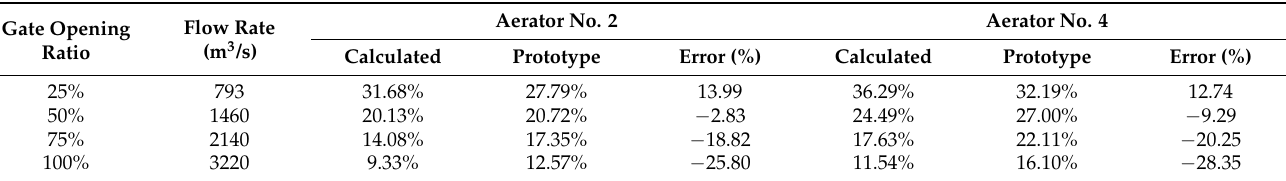
Table 3. The average aeration concentration of cross-sections behind the aerators.